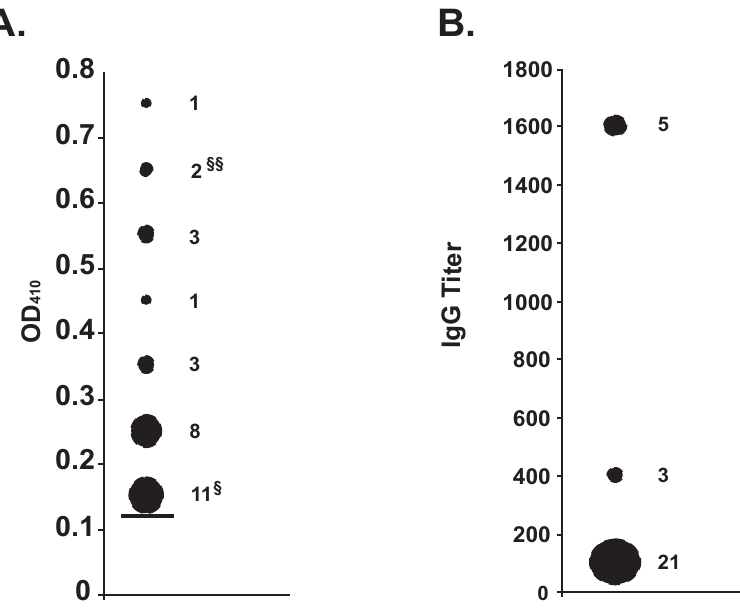
Figure 3. Marburg antibody testing in bats collected at locations where PCR positive bats were found. A.) Corrected OD values from bat sera diluted 1:100 that are greater than the threshold value of 0.13 (solid horizontal bar) which was calculated as the average corrected OD of the negative control group ( E. franqueti , N=47) plus 3 standard deviations. The numbers of sera specimens used to calculate the values are shown to the right of the corresponding symbol. OD values from nested-PCR positive bats 1448, 2296 ( 11 ) and 1631 ( 1 ) are also noted. B.) Antibody titers of sera specimens with corrected OD values greater than 0.13. The numbers of serum specimens used to calculate the values are shown to the right of the corresponding